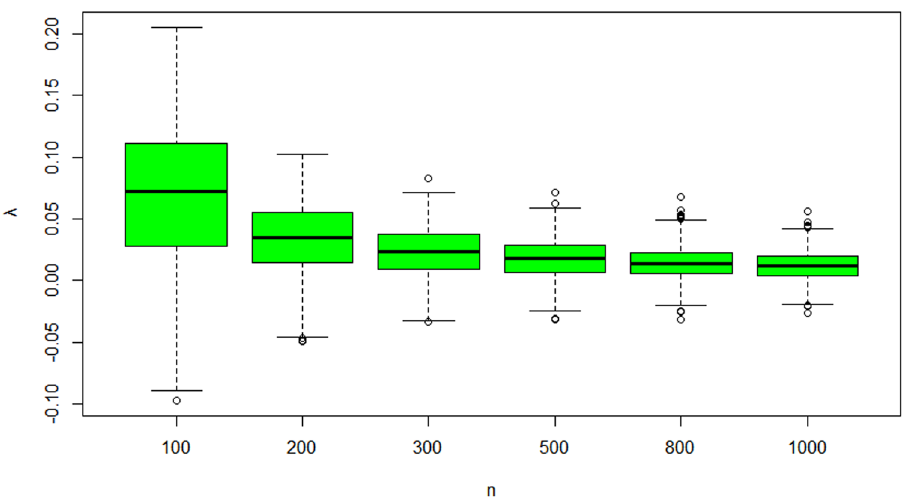
with = β 5 and = β 3 0 1